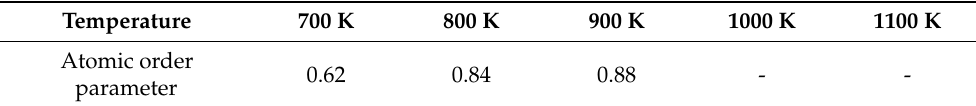
Table 1. L2 1 atomic order parameters obtained from in situ XRD (X-ray diffraction)